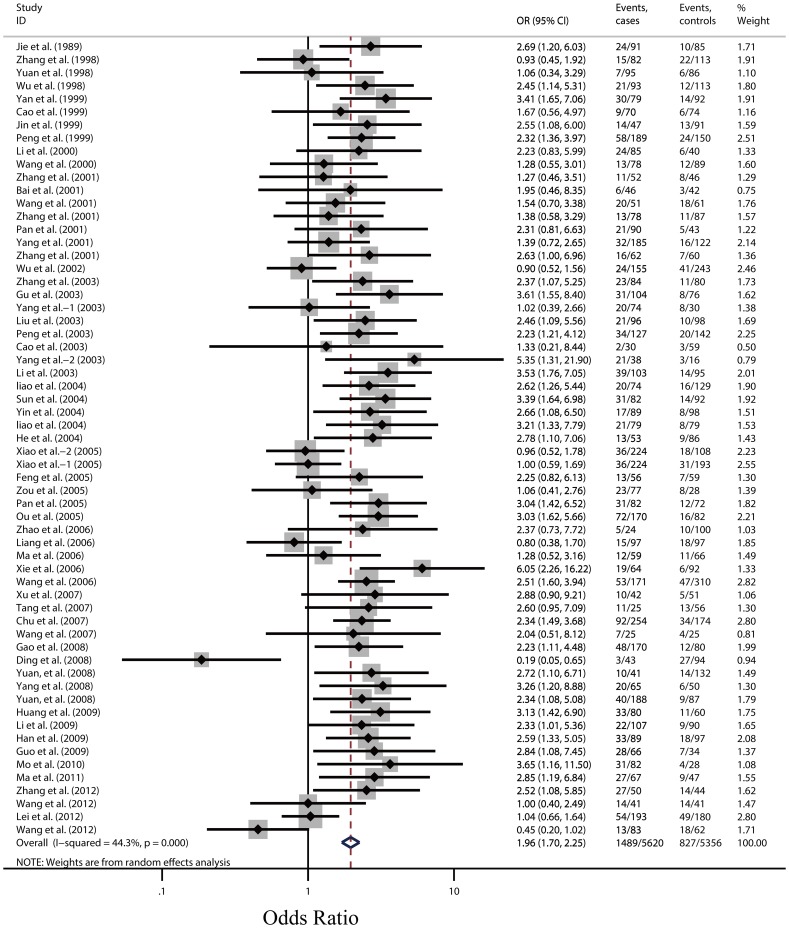
Odds ratios for coronary heart disease in ε4 carriers versus population with the ε3/3 genotype of all 61 studies.Size of the squares is proportional to the weight of the odds ratios; black circular dots indicate the odds ratios; horizontal lines represent the 95% CI. Dark hollow diamonds show the pooled estimates from the random-effects models (with 95% CI) and the fixed-effects model (with 95% CI).